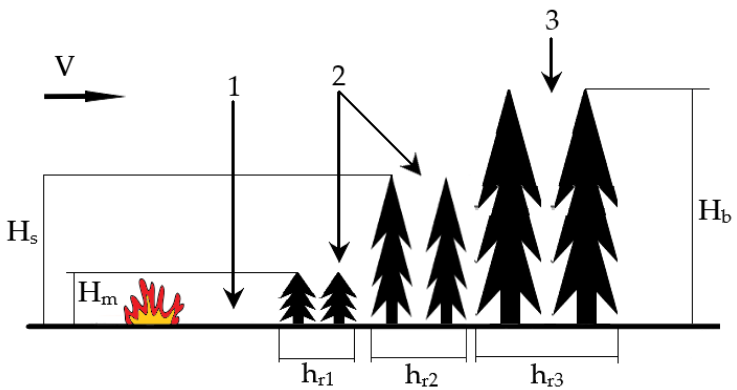
Figure 2. Scheme of the experimental site (side view): (1) “accelerating site” of a ground fire; (2) undergrowth and shrubs; (3) model forest canopy.